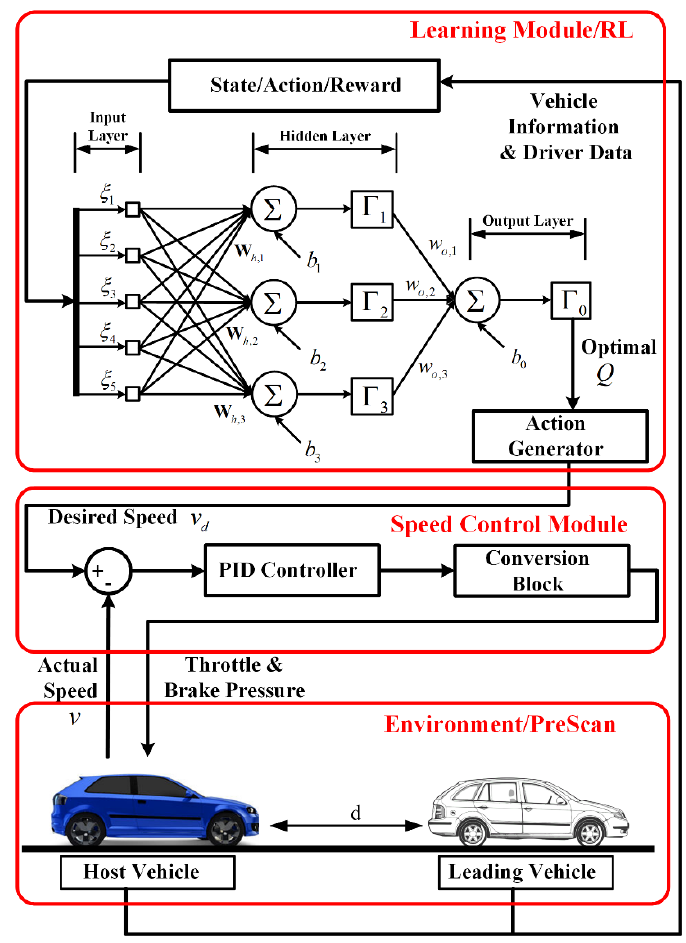
Figure 1. Architecture of the proposed personalized behavior learning system (PBLS). PID: proportion integration differentiation.